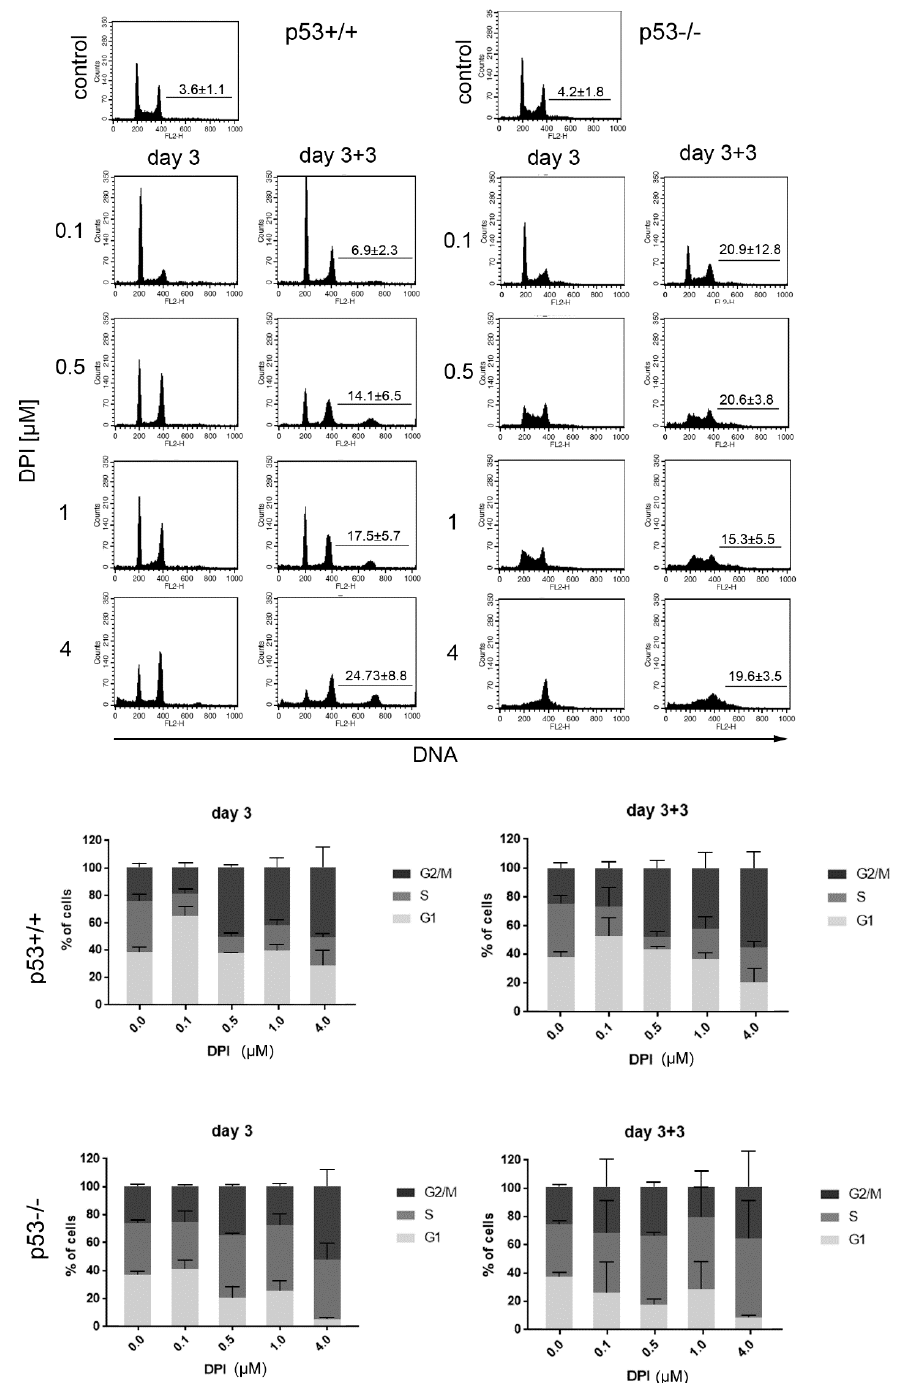
Figure 2. DPI disturbs cell cycle progression in HCT116 p53 +/+ and p53 − / − cells. HCT116 cells were treated with di ff erent concentrations of DPI and cell cycle distribution was analyzed 3 days after treatment and after subsequent culture in DPI-free medium. Representative histograms (upper panel) and graphs presenting distribution of cells in di ff erent phases of cell cycle. Mean values from 4 independent experiments ± SD. The mean number ( ± SD) of polyploid cells is marked on each histogram.